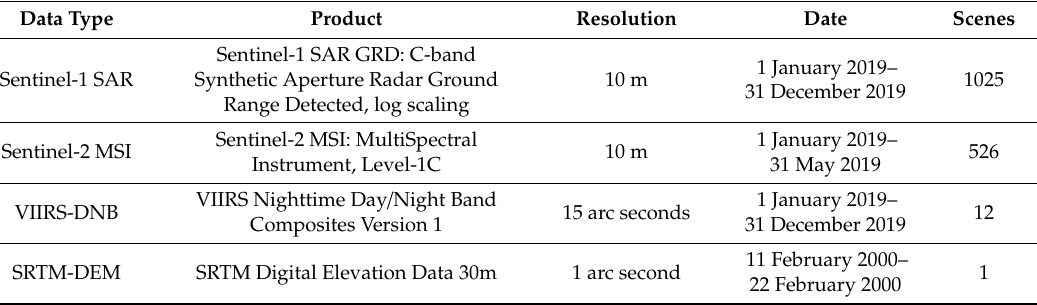
Table 1. List of the Sentinel-1 Synthetic Aperture Radar (SAR), Sentinel-2 MultiSpectral Instrument (MSI), Visible Infrared Imaging Radiometer Suite supporting a Day-Night Band (VIIRS-DNB) and Shuttle Radar Topography Mission-Digital Elevation Model (SRTM-DEM) data